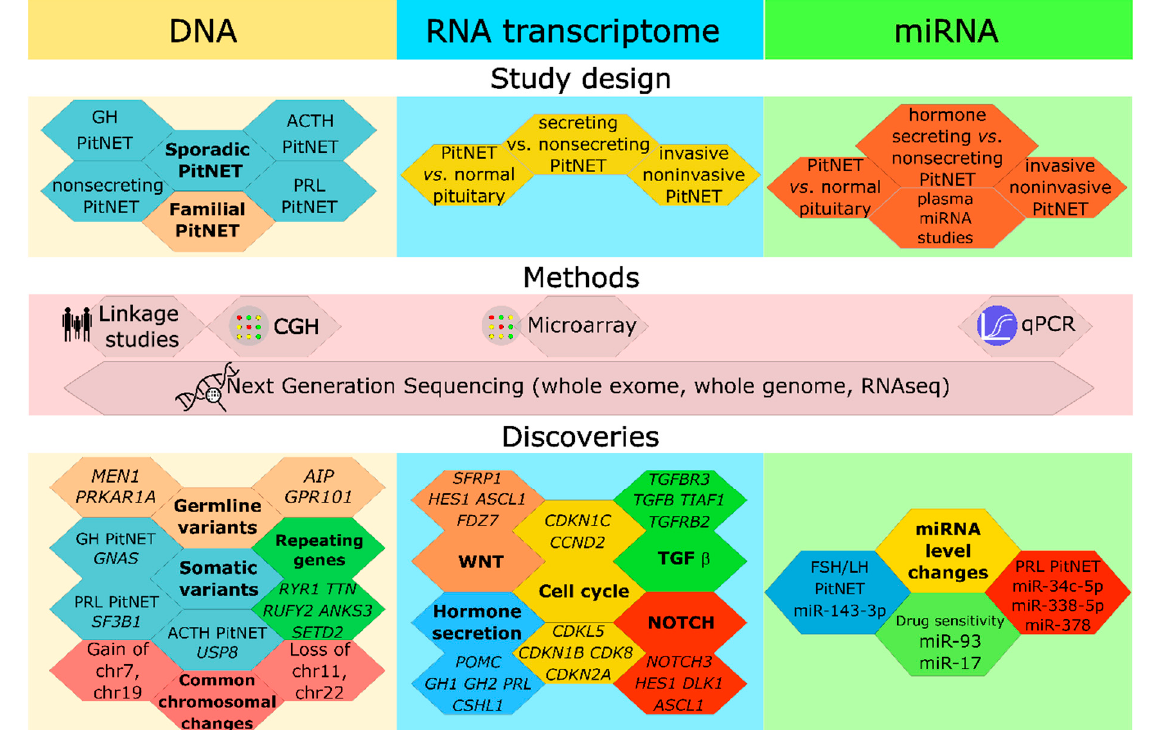
Figure 1. Summary of main “omics” studies in PitNETs grouped by investigated nucleic acid type. The top part shows the most popular study designs by molecule type. The middle section represents the most common methods, with next-generation sequencing having a central role in the investigation of PitNET nucleic acids nowadays. The selection of main discoveries is displayed in the lower part of the figure with the colour encoding of the nucleic acid origin, signalling pathways or related description of the relation of the discoveries to certain study design.